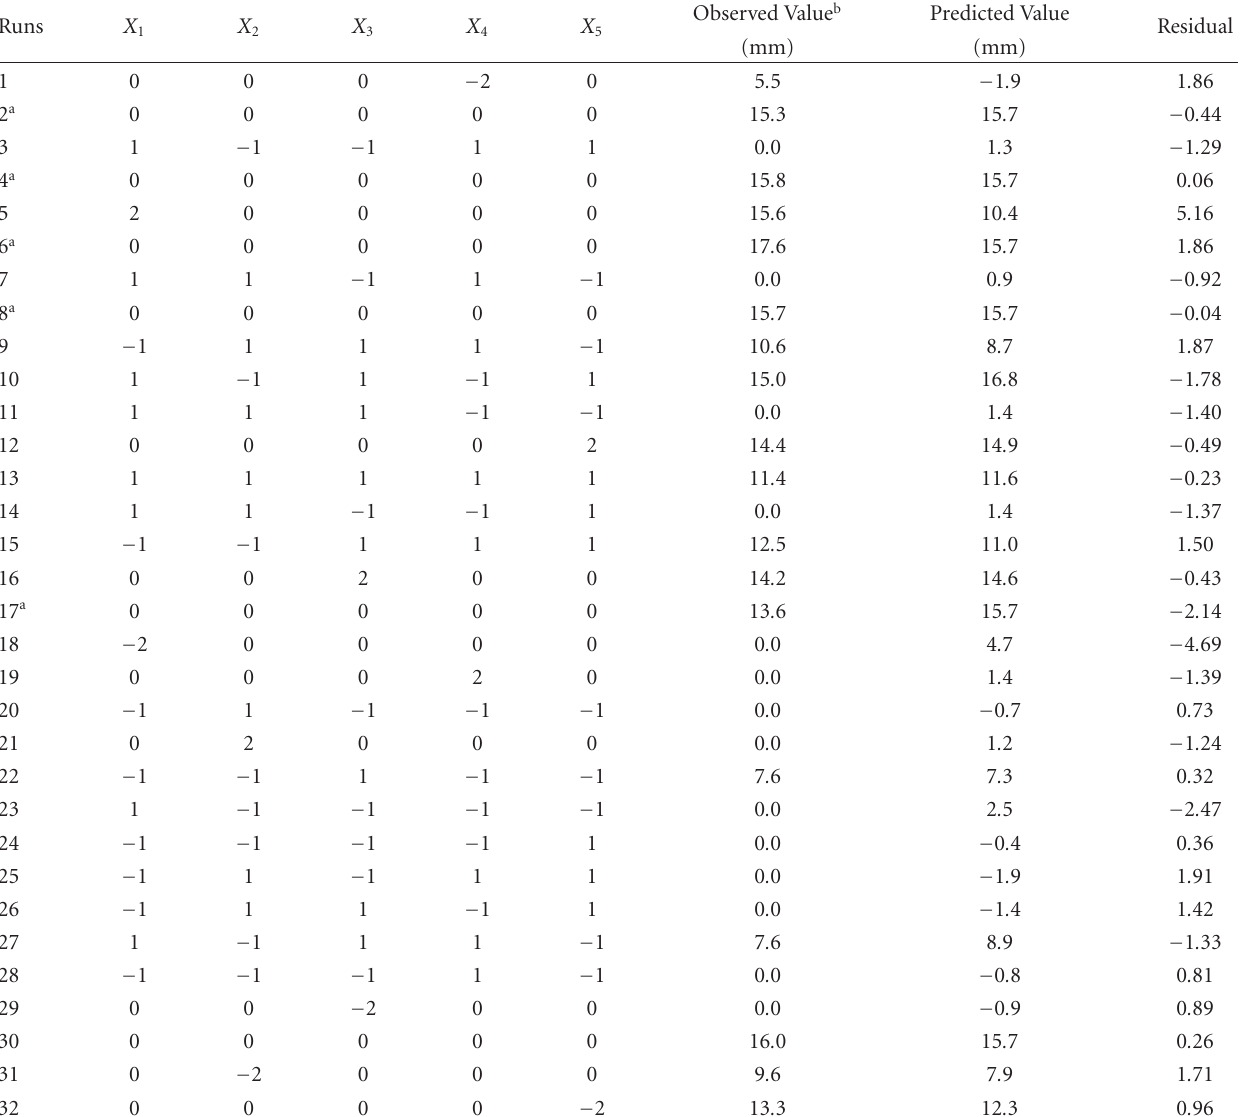
Table 5: Experiment design and results of the optimization of strain Hhs.015 T fermentation conditions using Response Surface